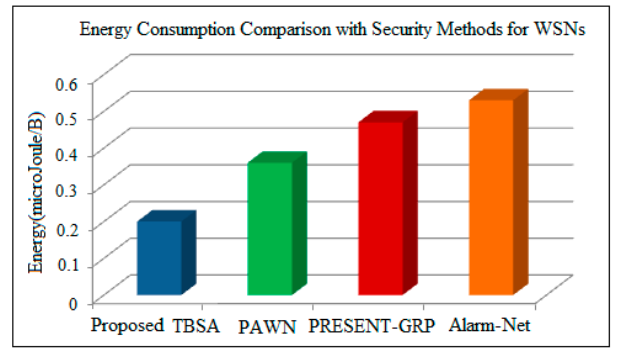
Figure 12. Energy consumption comparison of proposed TBSA with security mechanisms developed for WSNs.